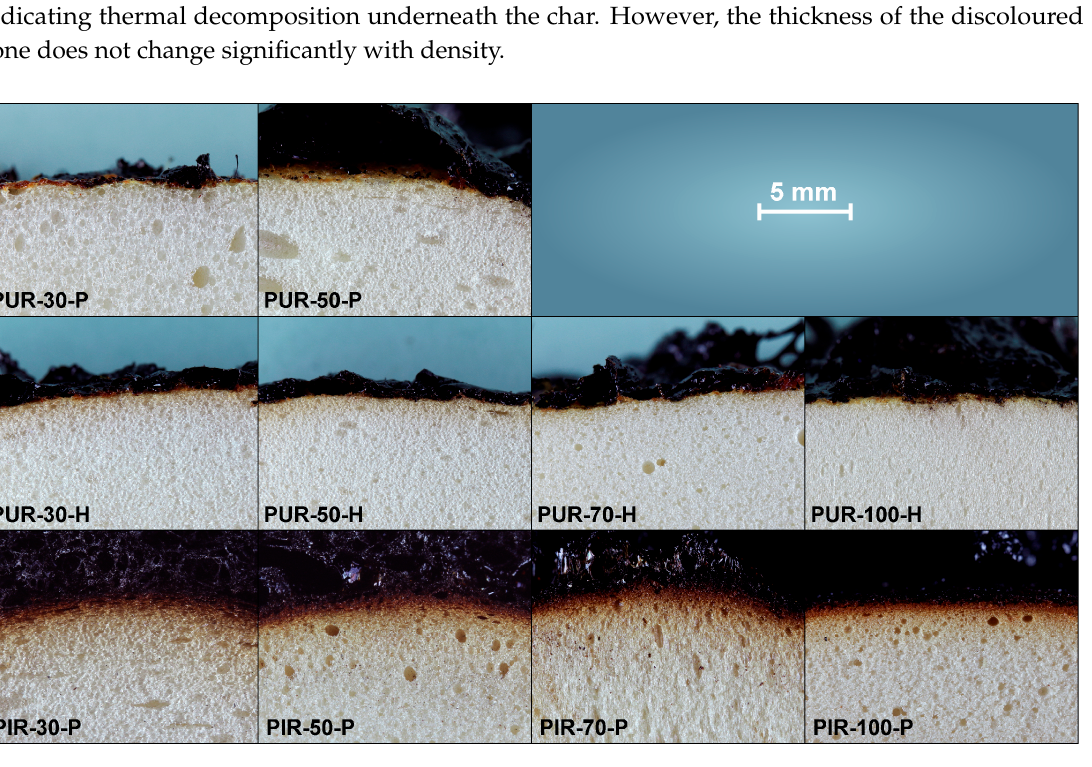
Figure 12. SEM micrographs of cross sections of quenched samples. Examination of the cross sections of PIR-P foams showed different behaviour. Instead of a clear pyrolysis front, a pyrolysis zone was observed. It is assumed that the inherent char yield of PIR foams, which is different from PUR, is the reason for this phenomenon. The SEM micrographs in Figure 13 indicate that the morphology of the foam is retained in the residue to some degree or that at least the char is built up in a foam-like structure. Thus, under forced-flaming conditions PIR-P foams yield a more effective protective layer than do PUR foams with respect to their thermal insulating properties. Figure 13. SEM micrographs of PIR-70-P, structure of the ( a ) foam and ( b ) residues.